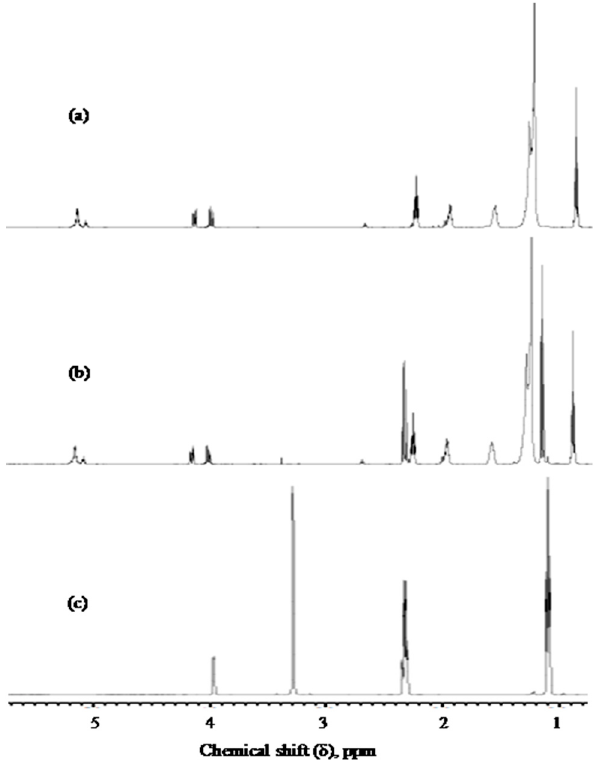
Figure 5. 1 H-NMR spectra of palm oil before extraction ( a ), oil-rich phase ( b ), and DES-rich phase ( c ); DES: betaine monohydrate-propionic acid with a mole fraction of acid of 0.89.